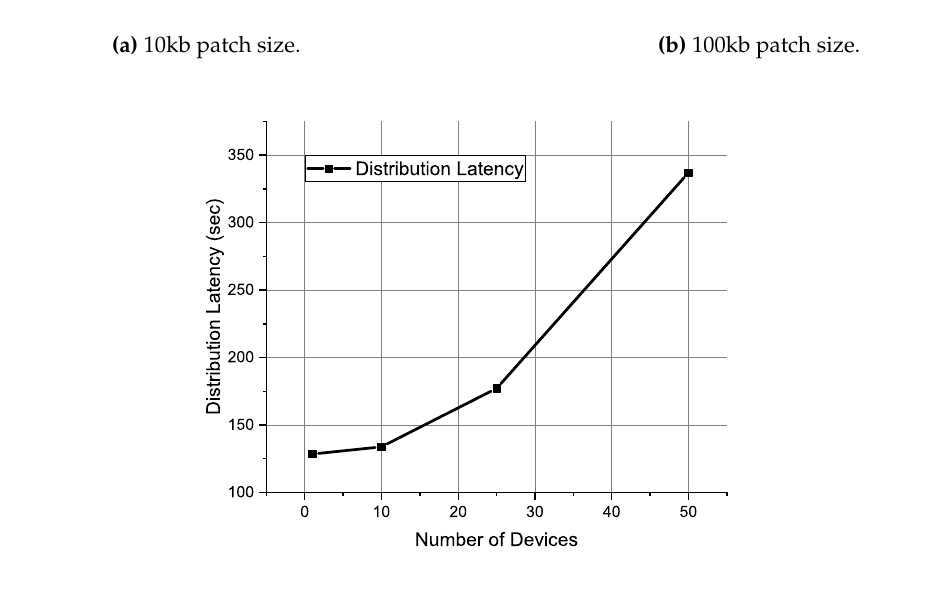
(c) 1mb patch size. Figure 5. Distribution latency for patch size ( a ) 10 kb, ( b ) 100 kb, and ( c ) 1 mb patch